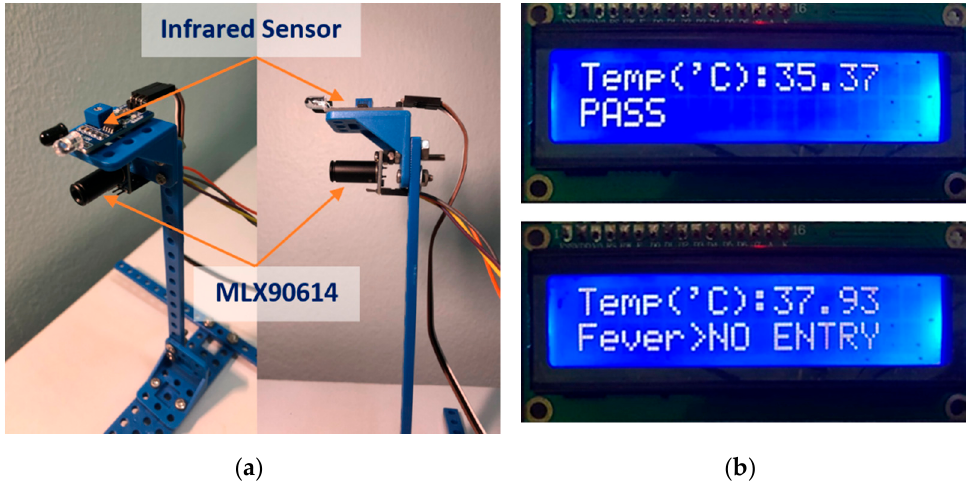
Figure 10. ( a ) Forehead MLX90614 thermometer prototype and ( b ) LCD displays either pass or no entry based on detected temperature with a limit of 37 °C.